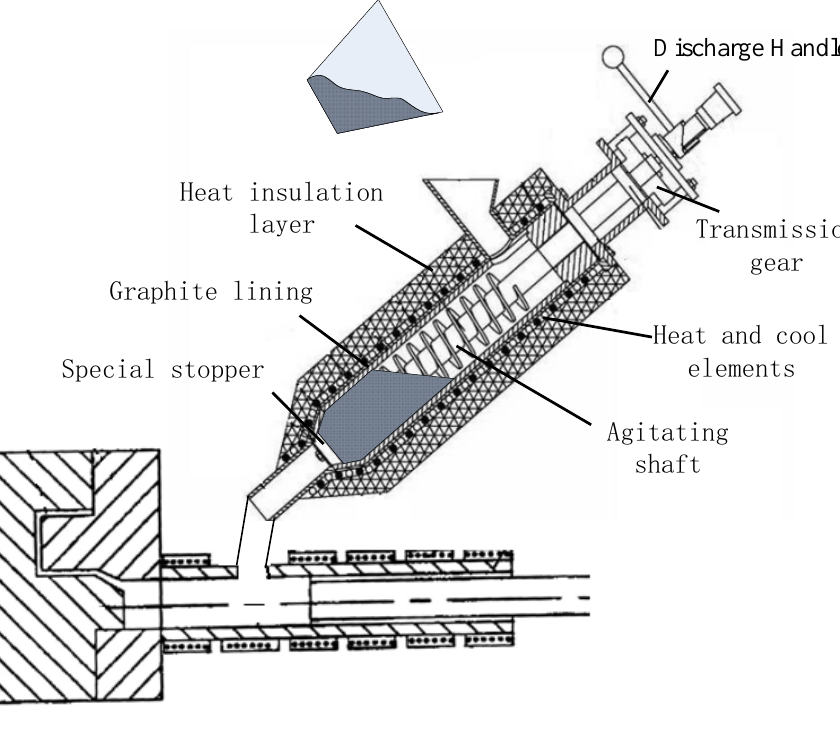
Figure 14. Schematic illustration of FCM-RHPDC process.